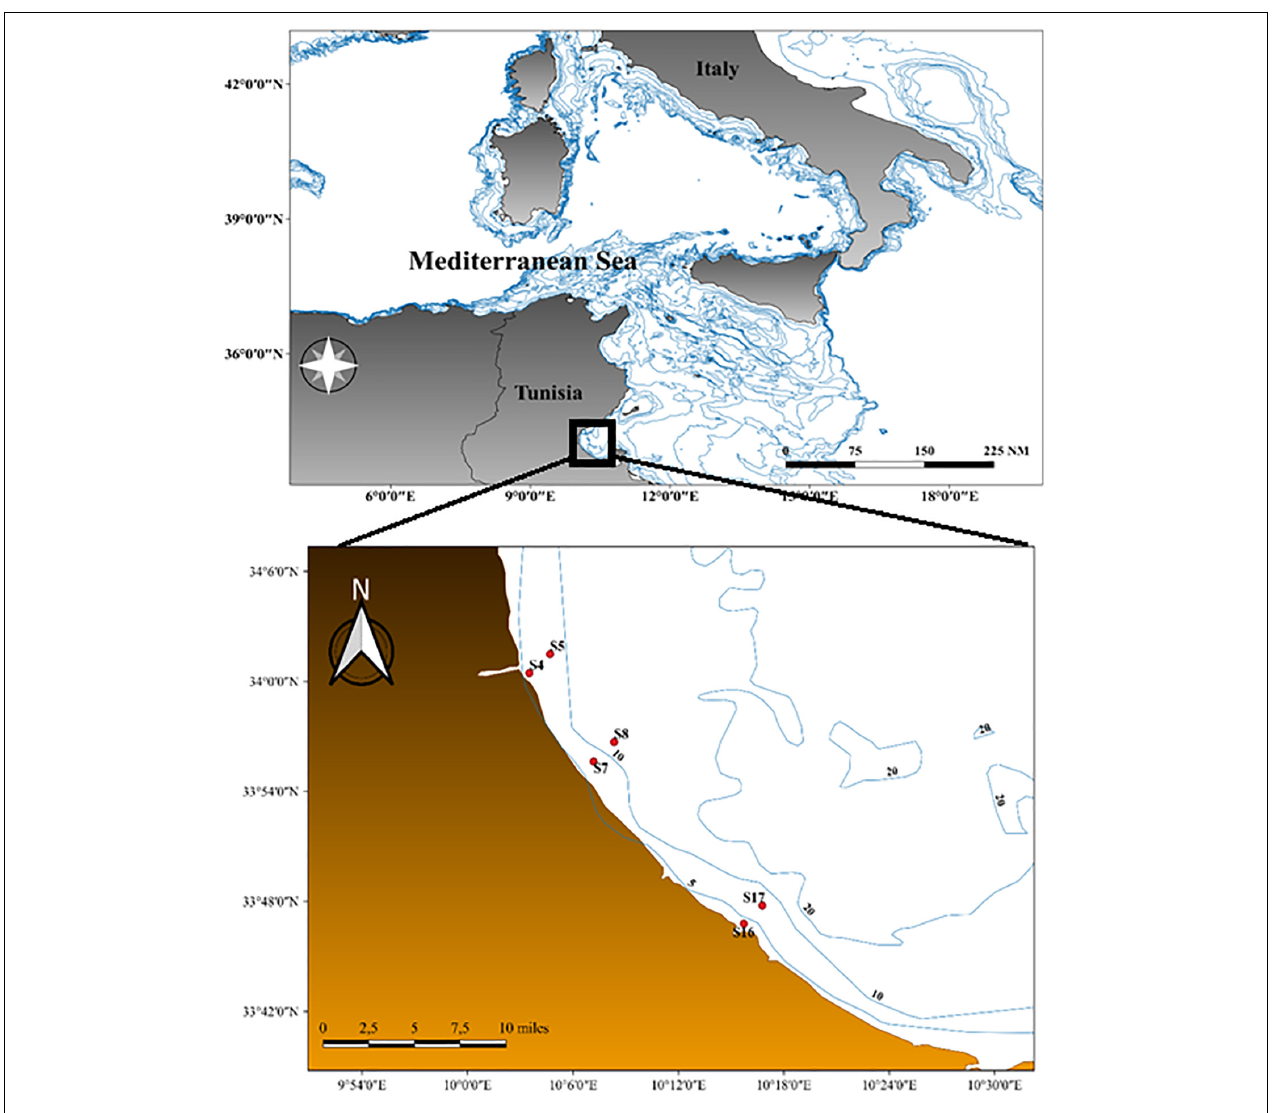
FIGURE 1 | Map showing the locations of the sampling stations in the Gulf of Gabes.